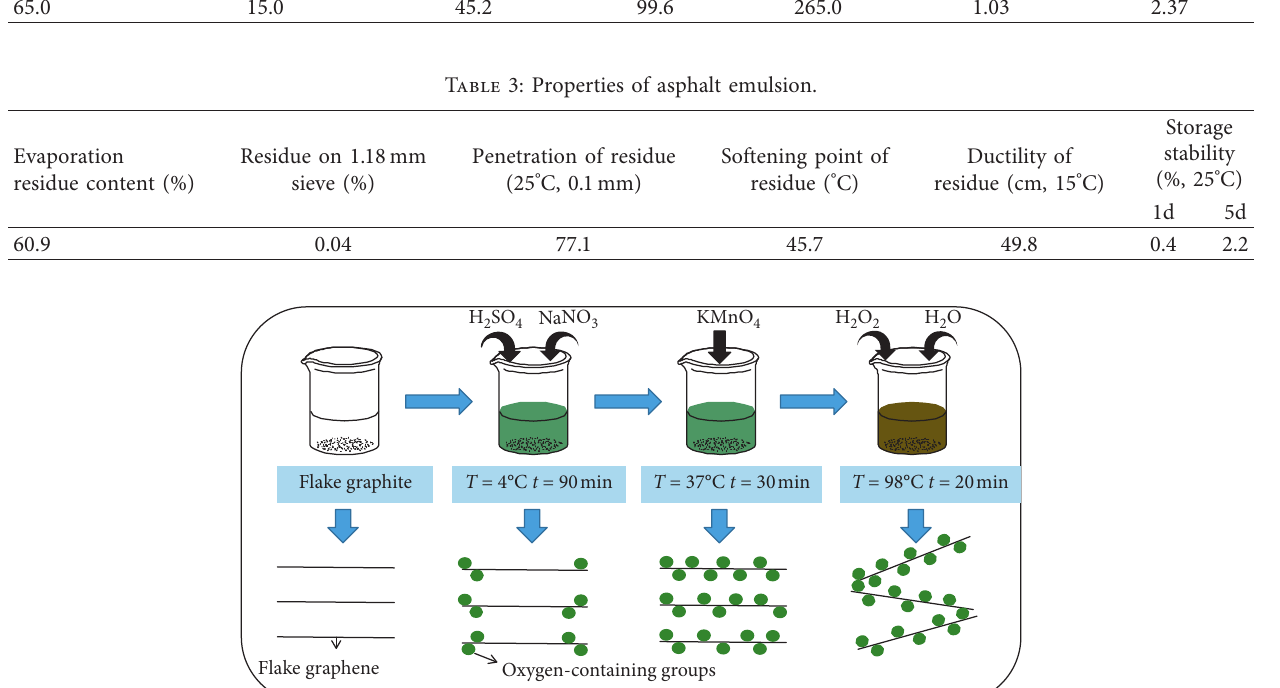
Figure 1: Schematic diagram of GO preparation by Hummers method.